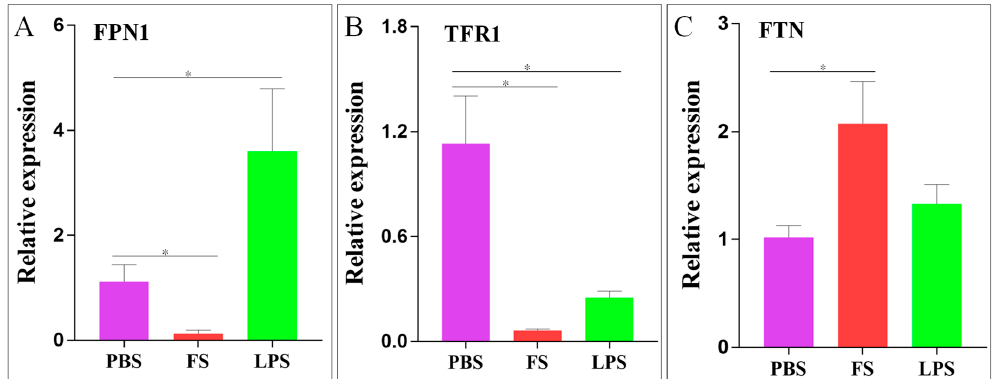
Figure 7. Differential expression of iron balance-related genes in the liver after FS or LPS injection.